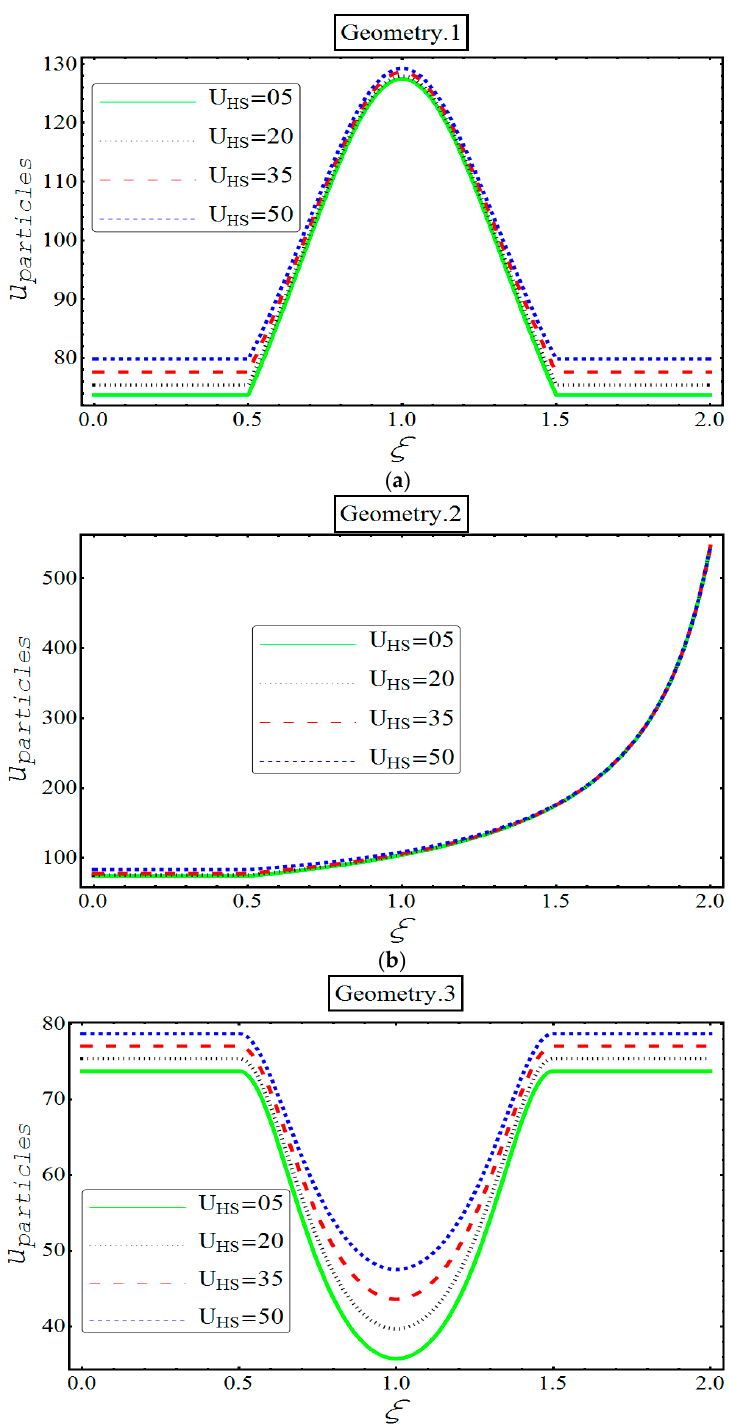
Figure 9. Variation of the velocity (cid:1873) (cid:3043) for various Helmholtz–Smoluchowski parameters.